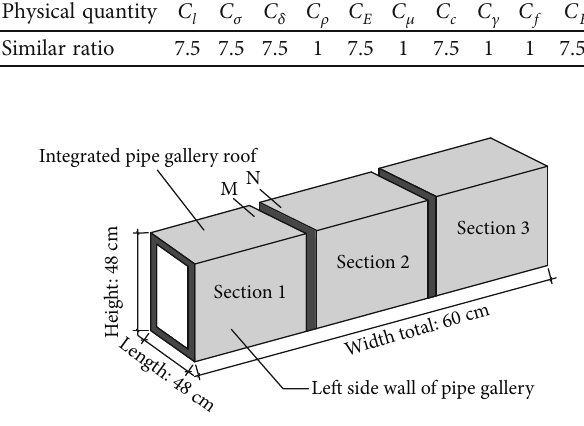
Figure 2: Elevation view of prefabricated pipe gallery.